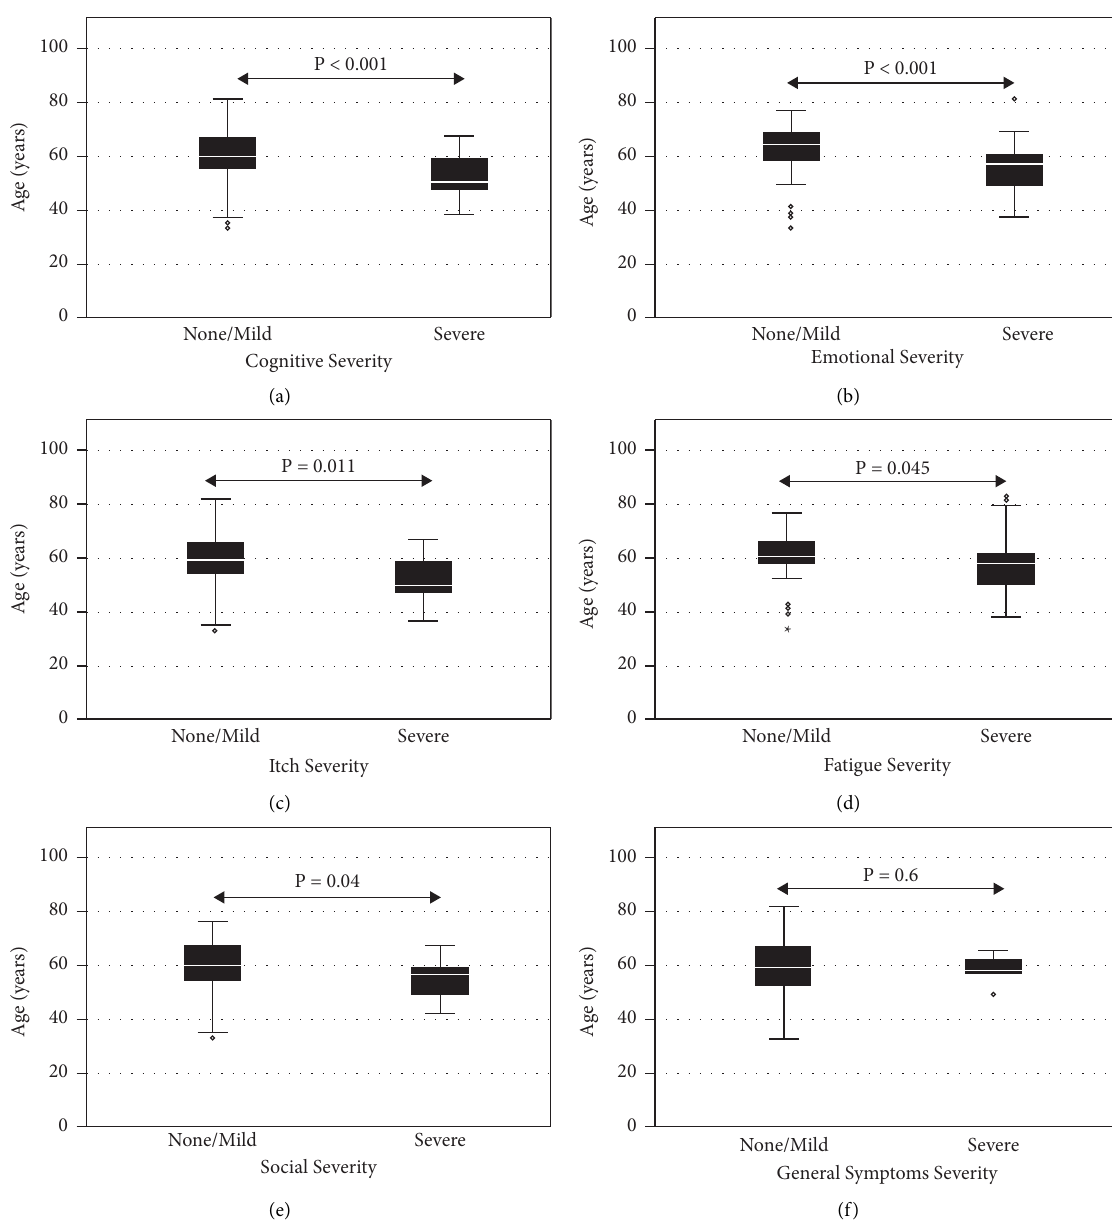
Figure 2: Symptom severity (none/mild vs. severe) as defned by the PBC-40 questionnaire domains, according to age (years). (a) Cognitive; (b) emotional; (c) itch; (d) fatigue; (e) social; (f) general